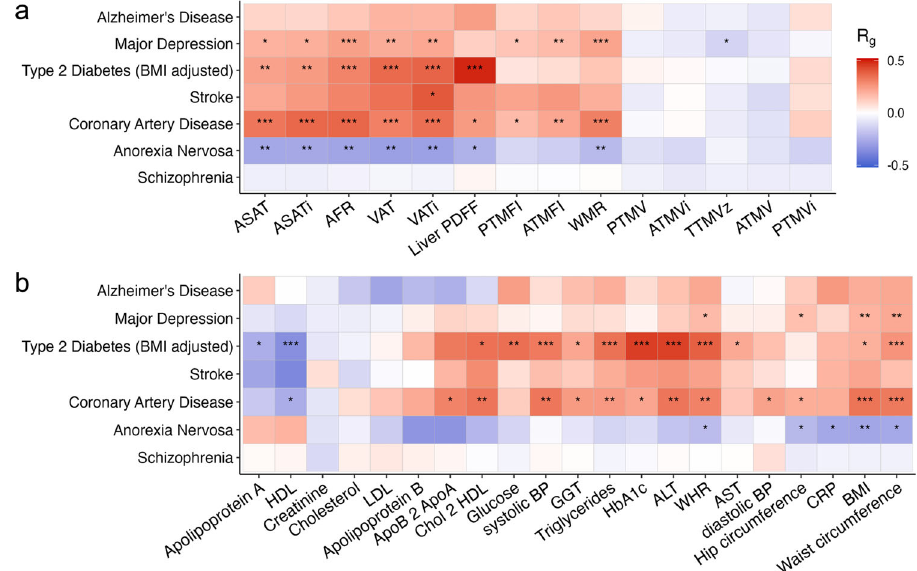
Fig. 5 Genetic correlations with conditions linked to poor cardiometabolic health. a Correlations for MRI-derived body composition measures on the x -axis. b These correlations for anthropometric and metabolic measure ( x -axis) with conditions linked to poor cardiometabolic health ( y -axis). *** p = 5 × 10 − 9 , ** p = 5 × 10 − 6 , * p = 5 × 10 − 4 .